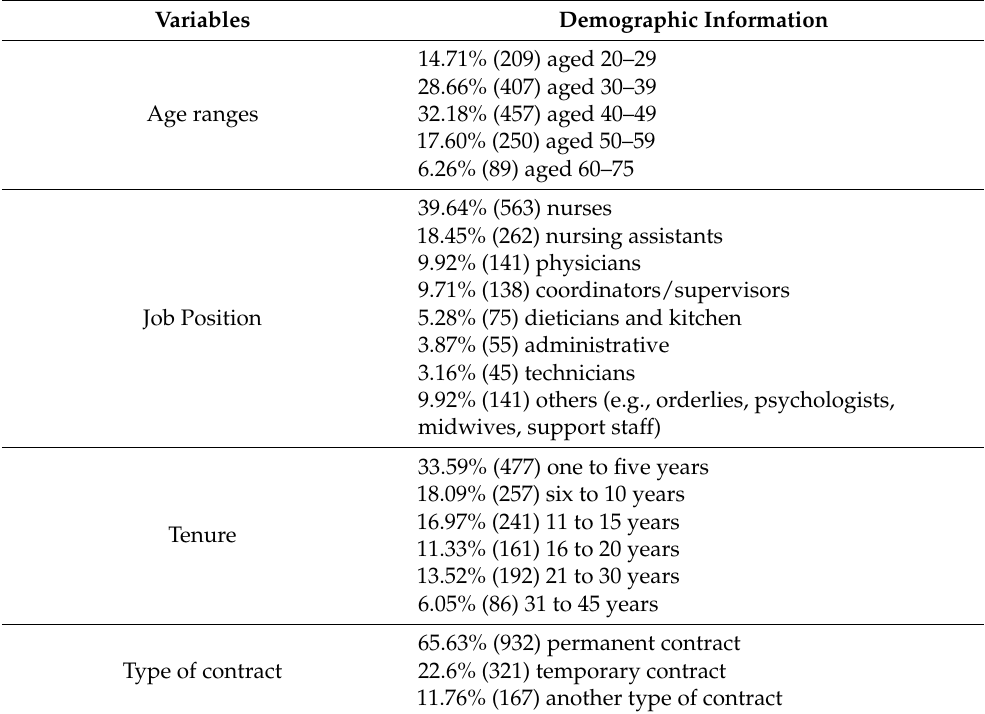
Table 1. Sociodemographic information of the participants (N = 1420).